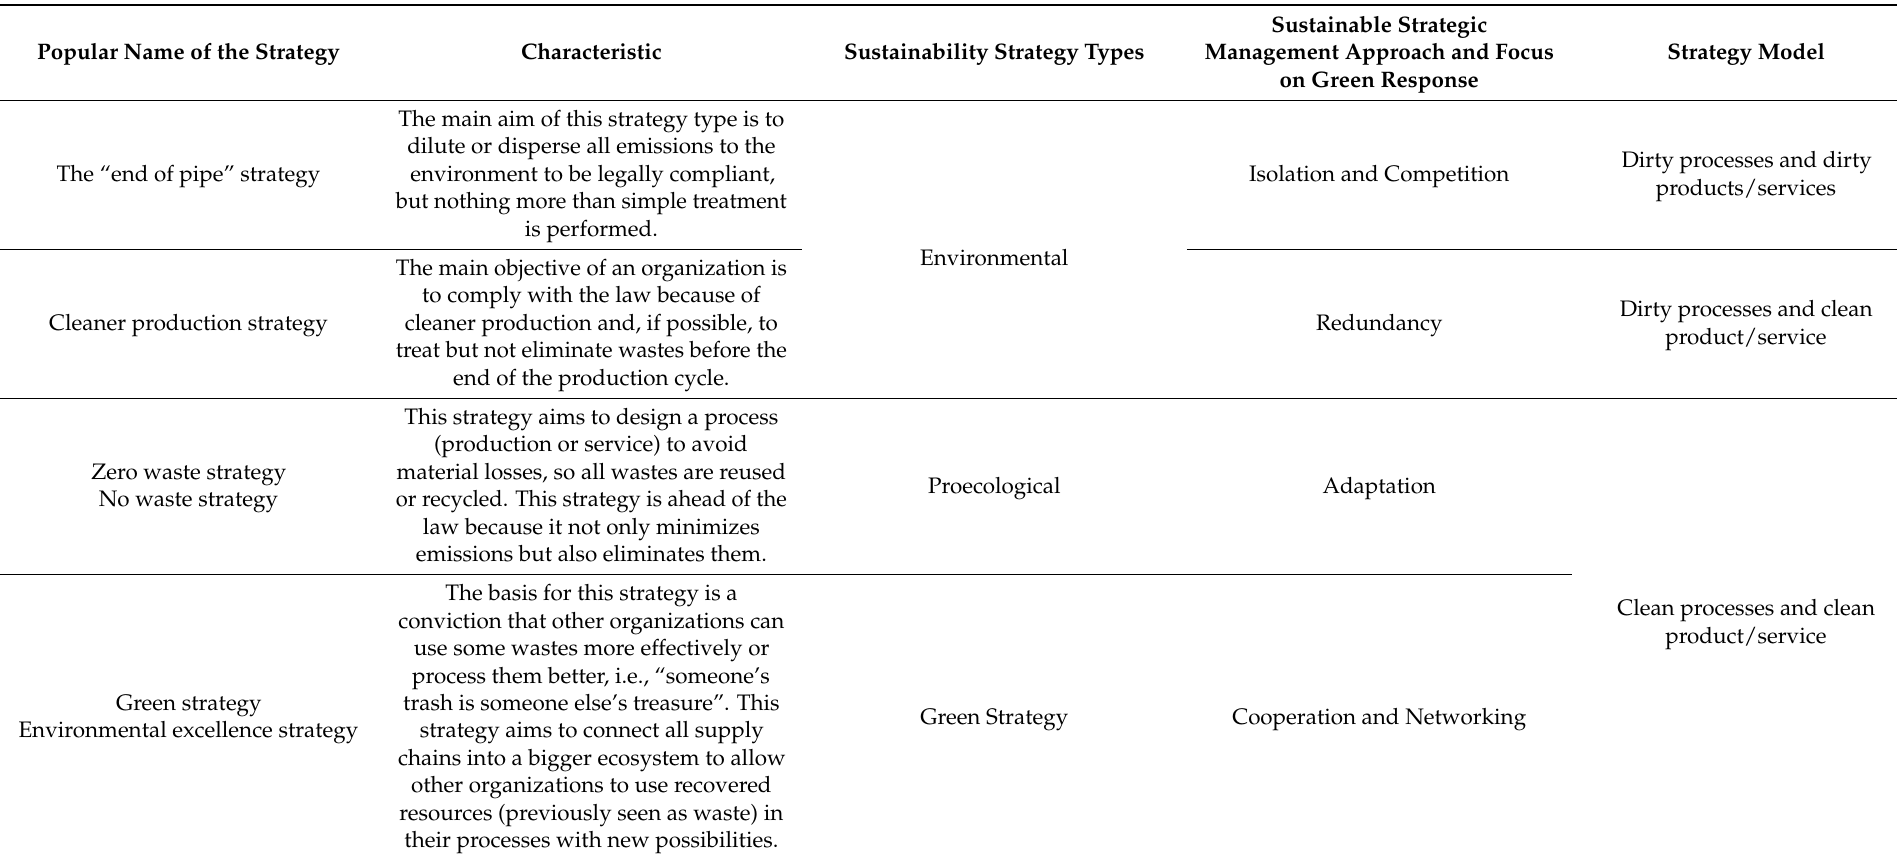
Table 5. Strategies evolution-based